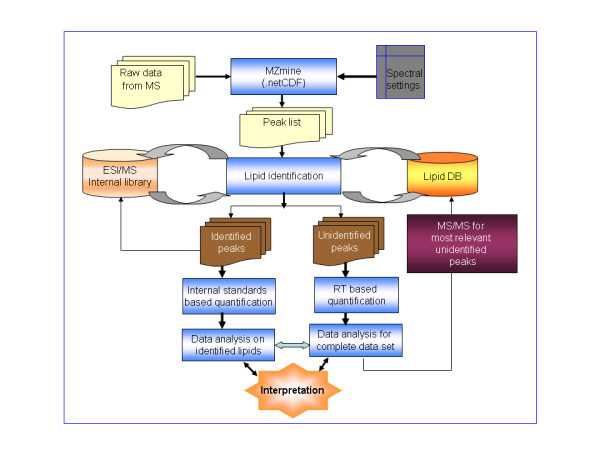
Lipidomic platform data flow. Summary of our lipidomic platform data flow from raw peak data to interpretation of spectra involving MZmine based data processing, lipid identification, quantification and multivariate data analysis.